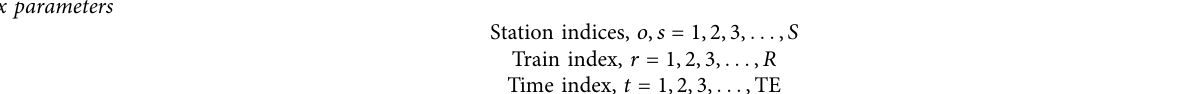
Table 2: Index, parameters, and variables.